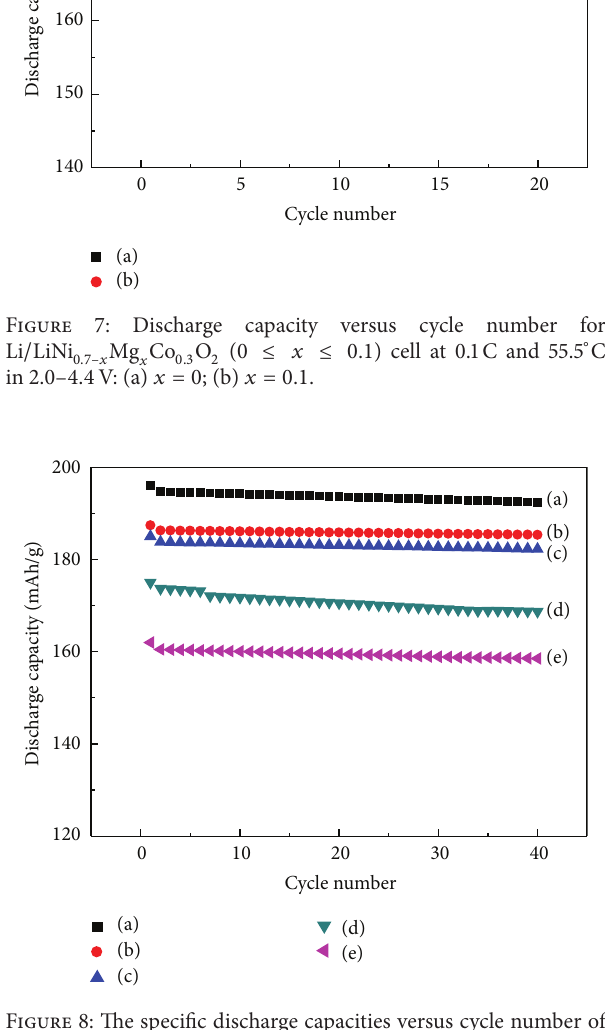
Figure 8: The specific discharge capacities versus cycle number of Li / LiNi 0.65 Mg 0.05 Co 0.3 O 2 cells at different rate 0.1C, 0.2 C, 0.3 C, 1C, and 2 C in the voltage range 2.0–4.6 V ( ( a ) = 0.1 C; ( b ) = 0.2 C; ( c ) = 0.3 C; ( d ) = 1 C; ( e ) = 2